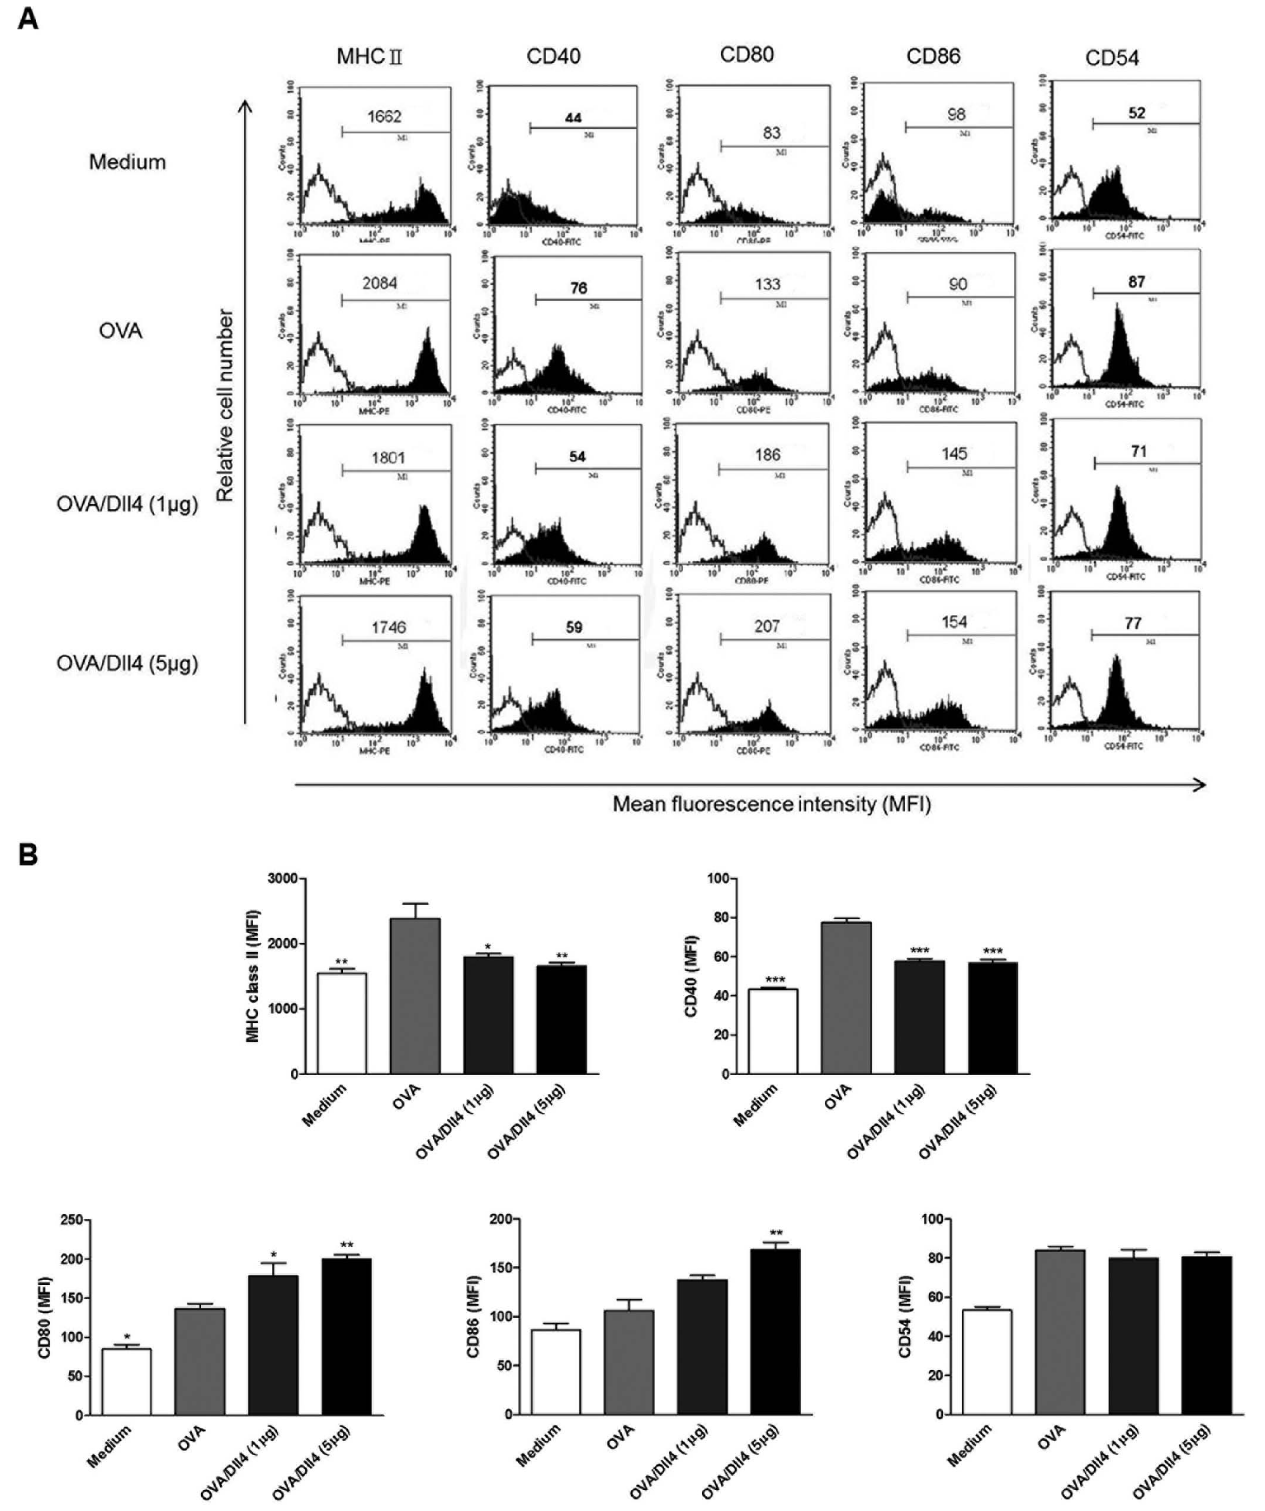
Figure 3. Dll4 pretreatment affects the phenotype of ovalbumin-stimulated dendritic cells. Dll4-pretreated or untreated immature dendritic cells (DCs) were or were not stimulated with ovalbumin (OVA) for 24 h. After incubation, cells were collected, and expression of MHC class II, CD40, CD54, CD80, and CD86 by DCs were analyzed using flow cytometry. DCs stimulated with only OVA (OVA group) were used as the positive control. (A) Values shown in the flow cytometric profiles are the mean fluorescence intensity (MFI). Values shown were from one representative experiment of 3 independent experiments performed. (B) The MFI was calculated, and results are expressed as the mean 6 SEM from 3 independent experiments. * p , 0.05, ** p , 0.01, *** p , 0.001 compared to OVA-treated DCs (OVA group). doi:10.1371/journal.pone.0063613.g003 PLOS ONE |